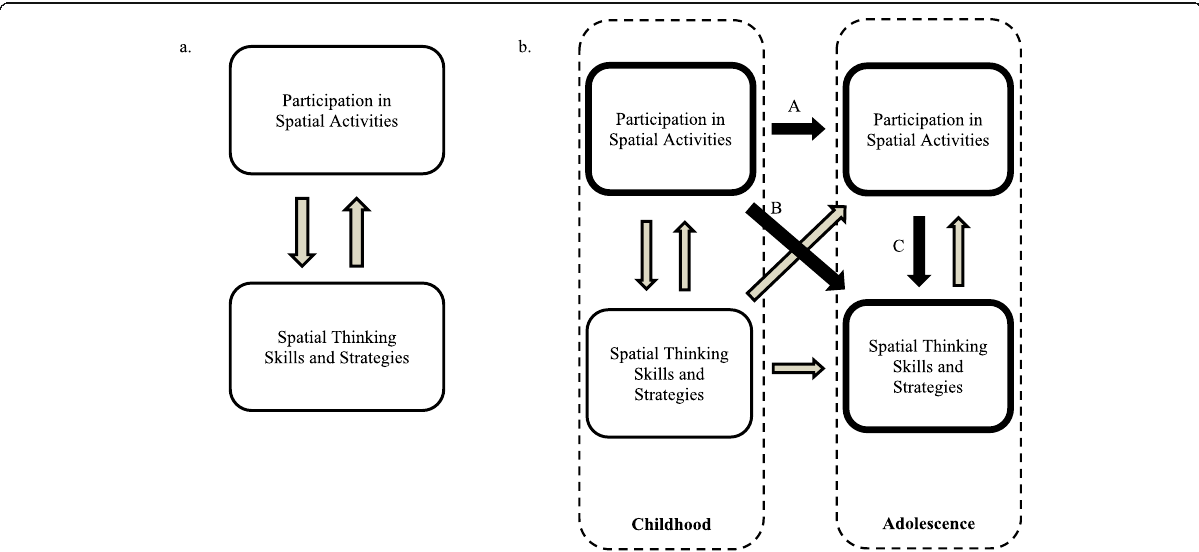
Fig. 1 Theoretical relations between spatial activities and spatial thinking. These relations are bi-directional in nature and can be examined at a single point in time ( 1a ) or across development ( 1b) . The bolded boxes and arrows represent the constructs and relations examined in the present